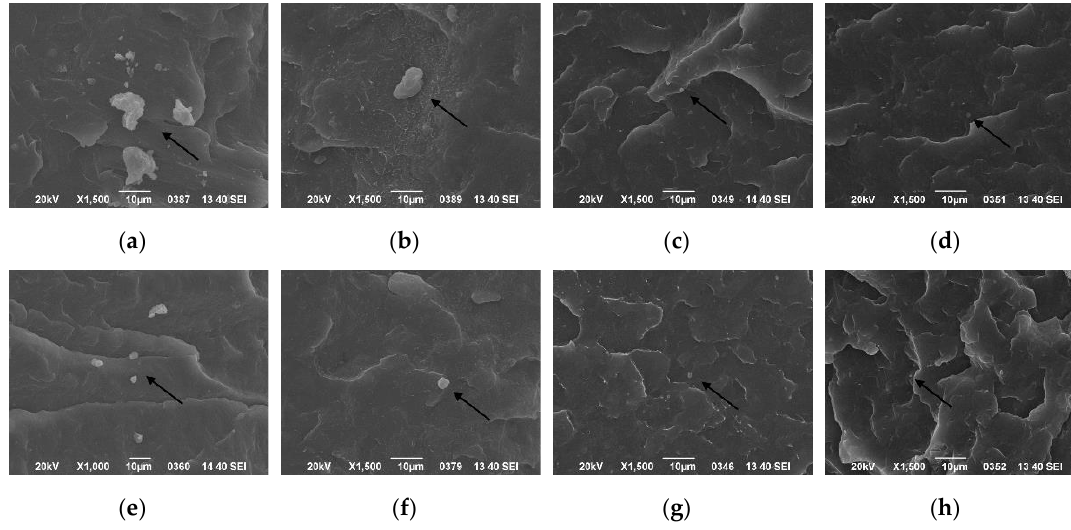
Figure 5. Dispersion of the nucleating agent under different cooling temperatures without ultrasound: ( a ) 30 °C, ( b ) 40 °C, ( c ) 50 °C, ( d ) 60 °C; and with ultrasound: ( e ) 30 °C, ( f ) 40 °C, ( g ) 50 °C, ( h ) 60 °C.